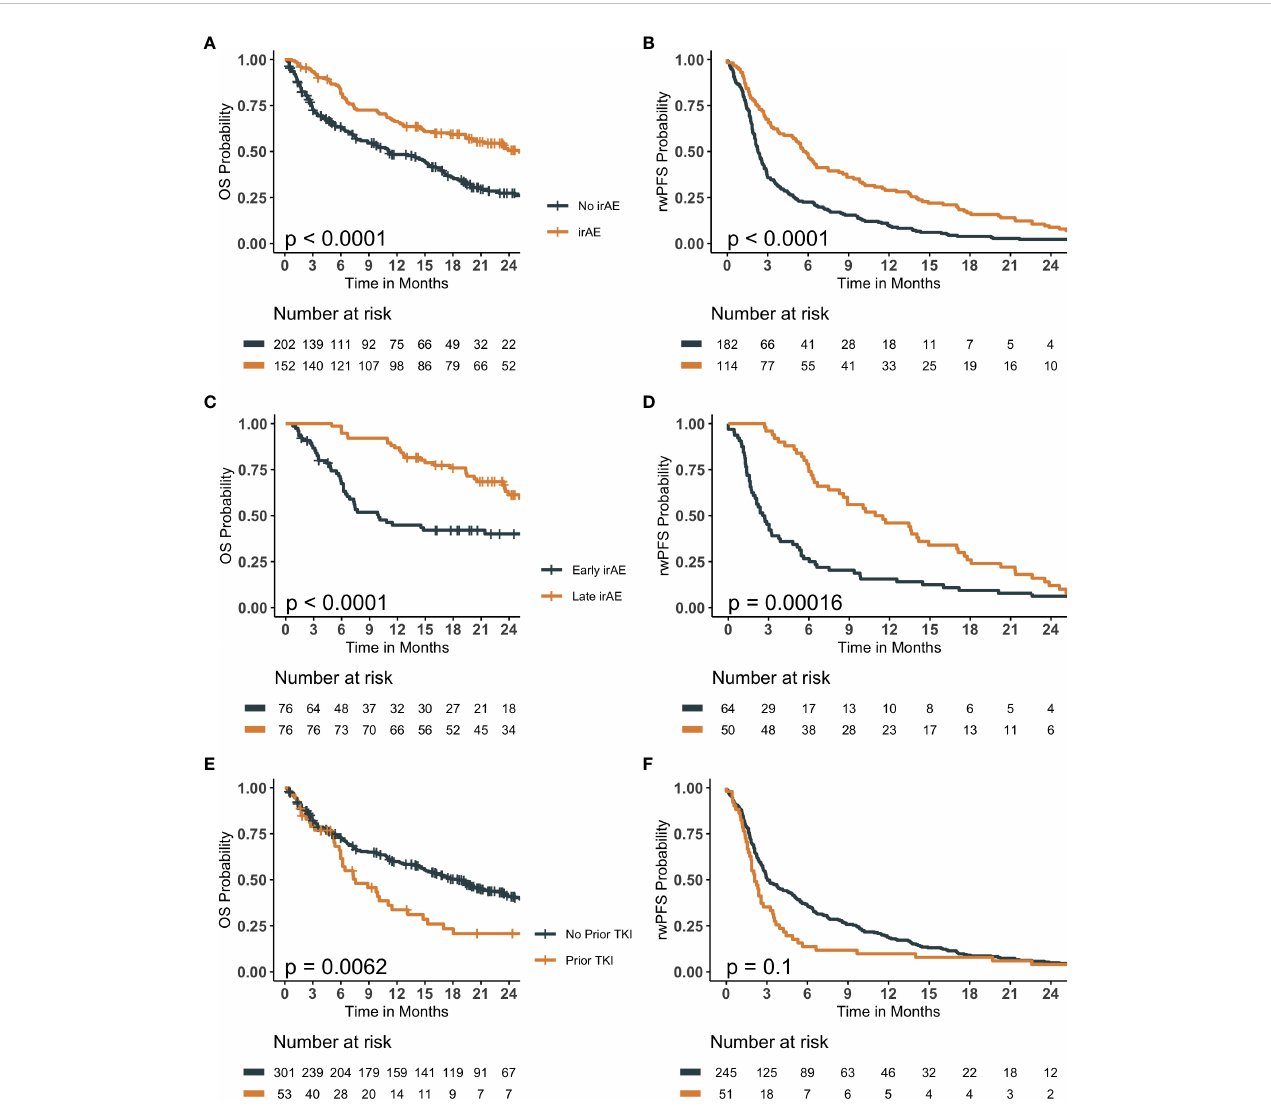
FIGURE 1 Kaplan Meier survival curves evaluating the role of immune-related adverse events (irAE) and history of tyrosine kinase inhibitor (TKI) therapy prior to immune checkpoint inhibitor (ICI) therapy on overall survival (OS) and real-world progression free survival (rwPFS). (A, B) compare patients experiencing an irAE to those that did not, evaluating OS and rwPFS, respectively. (C, D) compare patients experiencing an early-irAE to those experiencing a late-irAE event, evaluating OS and rwPFS, respectively. (E, F) compares patients who received a TKI prior to ICI therapy to those that did not, evaluating OS and rwPFS, respectively. All p-values are the result of a log-rank statistical test comparing the survival probability of the